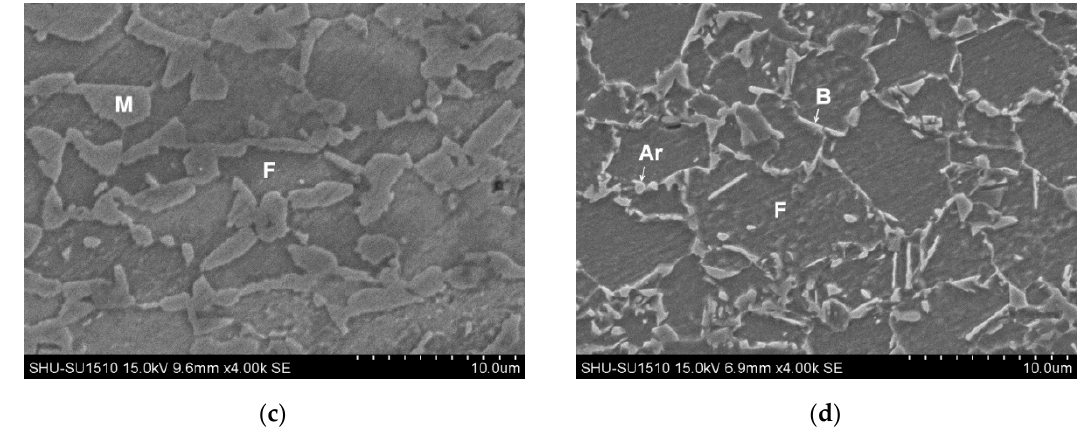
Figure 3. Optical micrographs of ( a ) Dual Purpose (DP) steel; ( b ) Transformation Induced Plasticity (TRIP) steel and SEM micrographs of ( c ) DP steel; ( d ) TRIP steel.